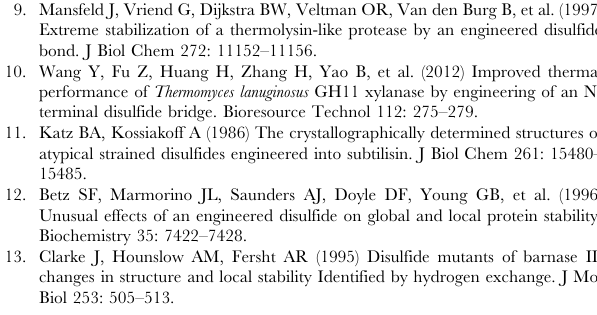
Figure S1 Alignment of the amino acid sequence of RCL, RNL and